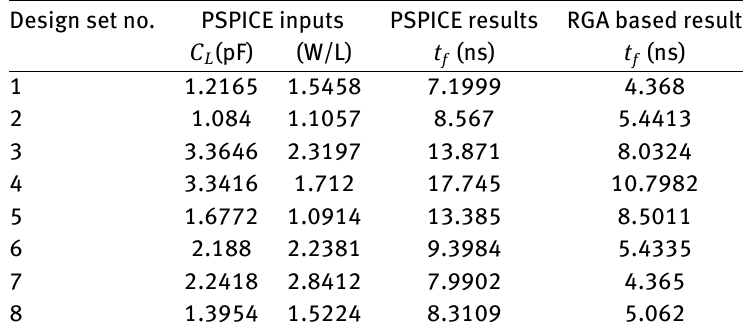
Table 9: PSPICE based results versus RGA based results for the Case study-1. Design set no.